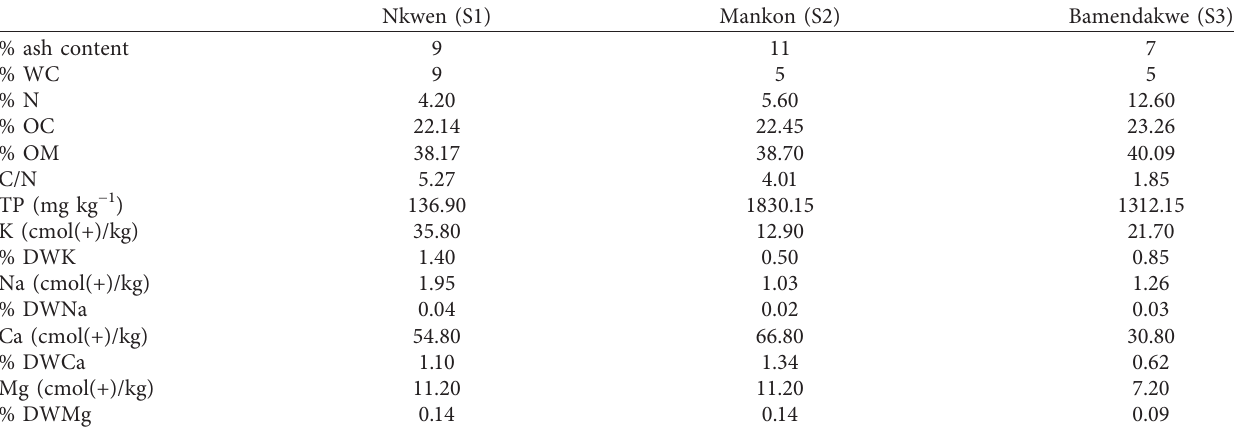
Table 2: Maize plant physicochemical properties.